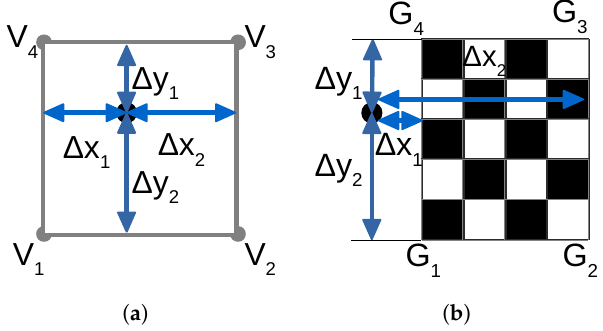
Figure 8. Cost definition for corner detection in the point cloud. ( a ) An example of the point falling into the wrong pattern. The square represents a white pattern of the chessboard; ( b ) An example of the point falling out of the chessboard model; ( a ) describes the first term and ( b ) describes the second term of the cost function (Equation